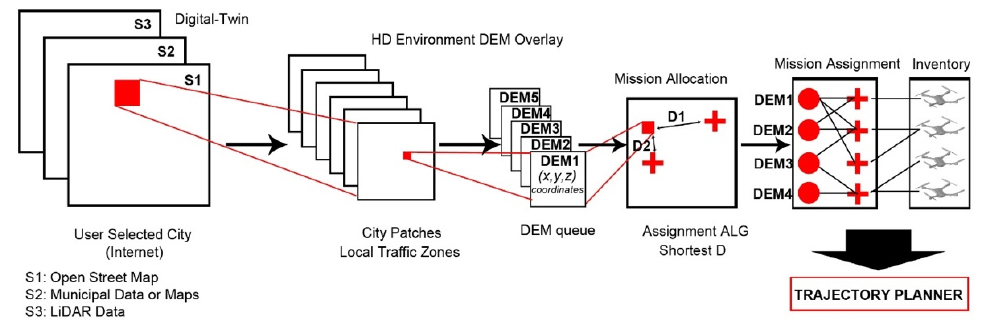
Figure 6. Proposed digital-twin mining framework.